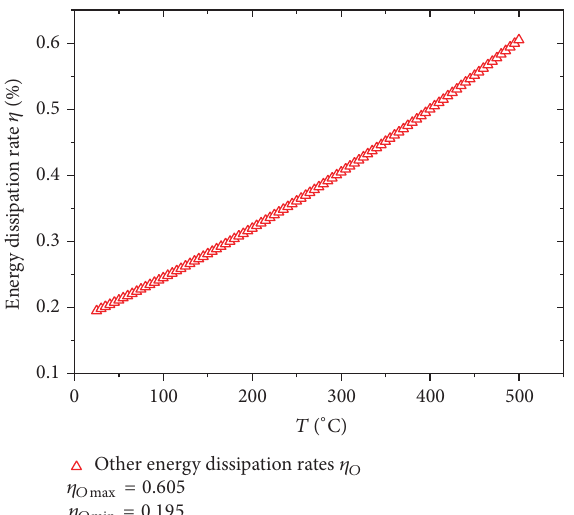
Figure 10: The relationship between other energy dispassion rates and